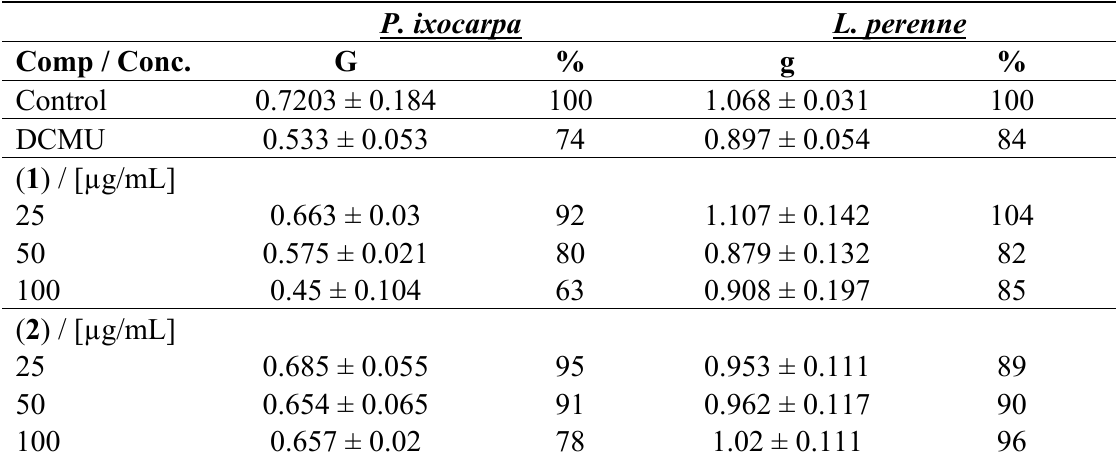
Table 2. Effects of 1 and 2 on biomass production in vivo (measured as dry weight of P. ixocarpa and L. perenne plants grown previously for 18 days before treatment). The data are results of five